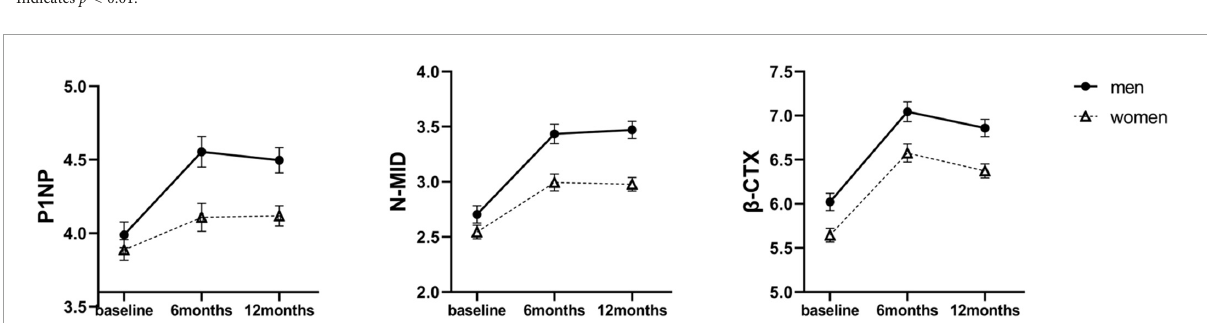
FIGURE2 Estimated marginal means (y-axis) of bone turnover markers for men and women group over time points (x-axis). Error bars indicate standard error. P1NP, procollagen type I amino-terminal propeptide; β -CTX, β -cross-linked C-telopeptide of type I collagen; N-MID, N-terminal